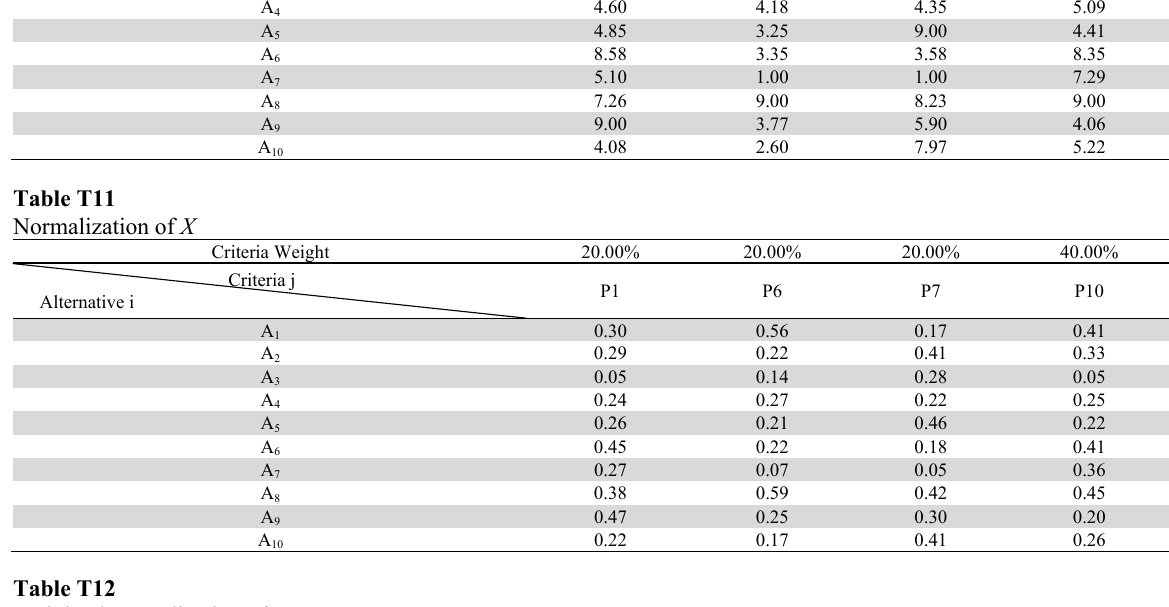
Initial criteria weights and alternative scores in X Criteria Weight